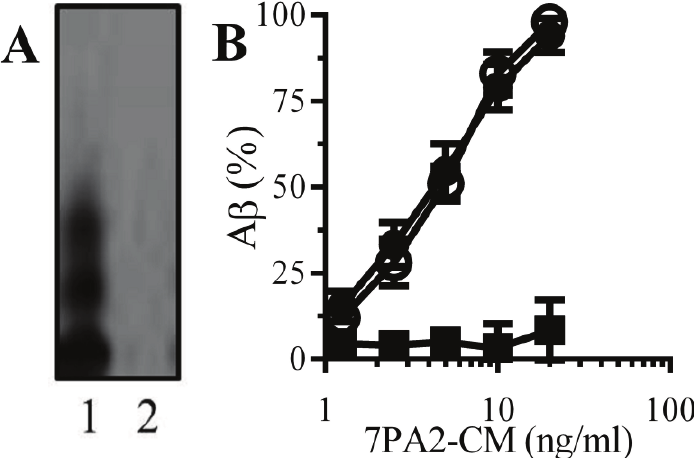
Figure 2. Aβ binds to monoacylated PrP C : ( A ) Immunoblots showing forms of Aβ in 7PA2-CM (1) and CHO-CM (2). ( B ) The amounts of Aβ detected in immunoplates coated with 10 nM PrP C (●), 10 nM monoacylated PrP C (○) or 10 nM monoacylated Thy - 1 (■) and incubated with 7PA2-CM as shown. Values are means ± SD from triplicate experiments performed 4 times ( n =